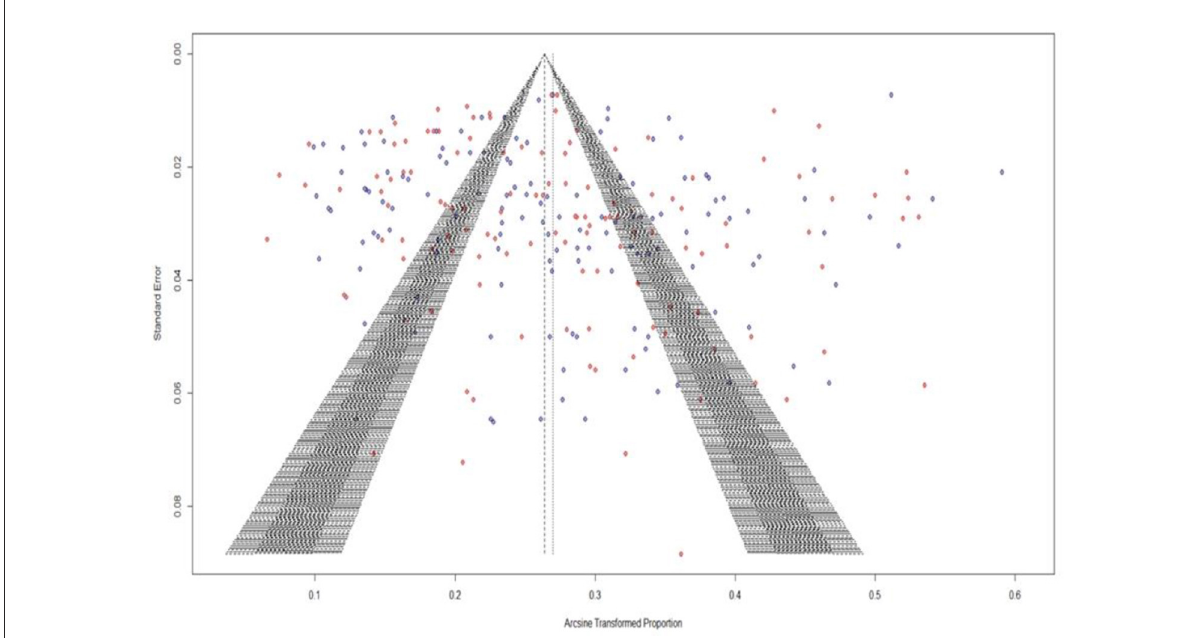
FIGURE2 Publication bias among studies is shown in funnel plots showing asymmetry and